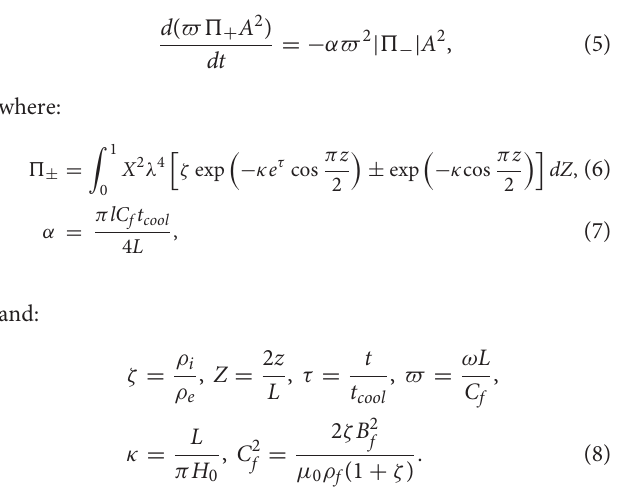
which the dimensionless amplitude is scaled, and set L / L c